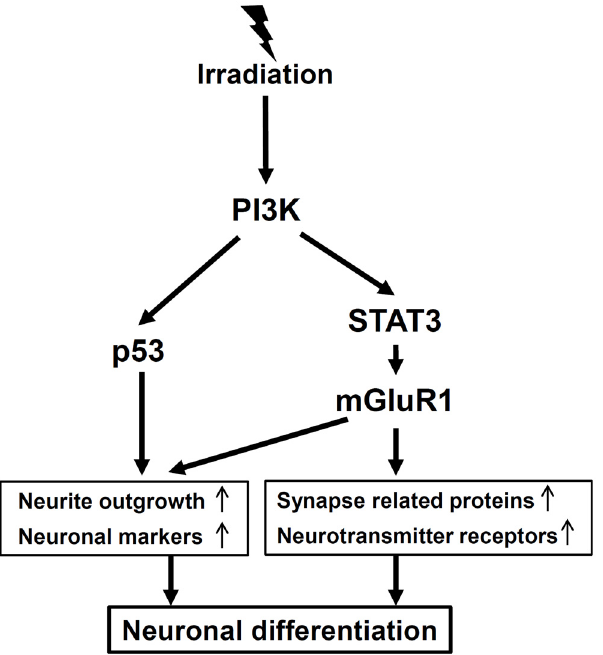
Fig 10. Schematic representation of signaling pathway in IR-induced neuronal differentiation. Ionizing radiation promotes the neuronal differentiation of C17.2 cells via two independent signaling pathways, PI3K- p53 and PI3K-STAT3-mGluR1. p53 and STAT3 may play as the downstream target of PI3K signaling in IR- induced neuronal differentiation of C17.2 cells. The activation of p53 via PI3K may be involved in the IR- induced neurite outgrowth and neuronal marker expressions. mGluR1 signaling of PI3K-STAT3 downstream may also be involved in the IR-induced neuronal function-related protein expressions as well as neurite outgrowth and neuronal marker